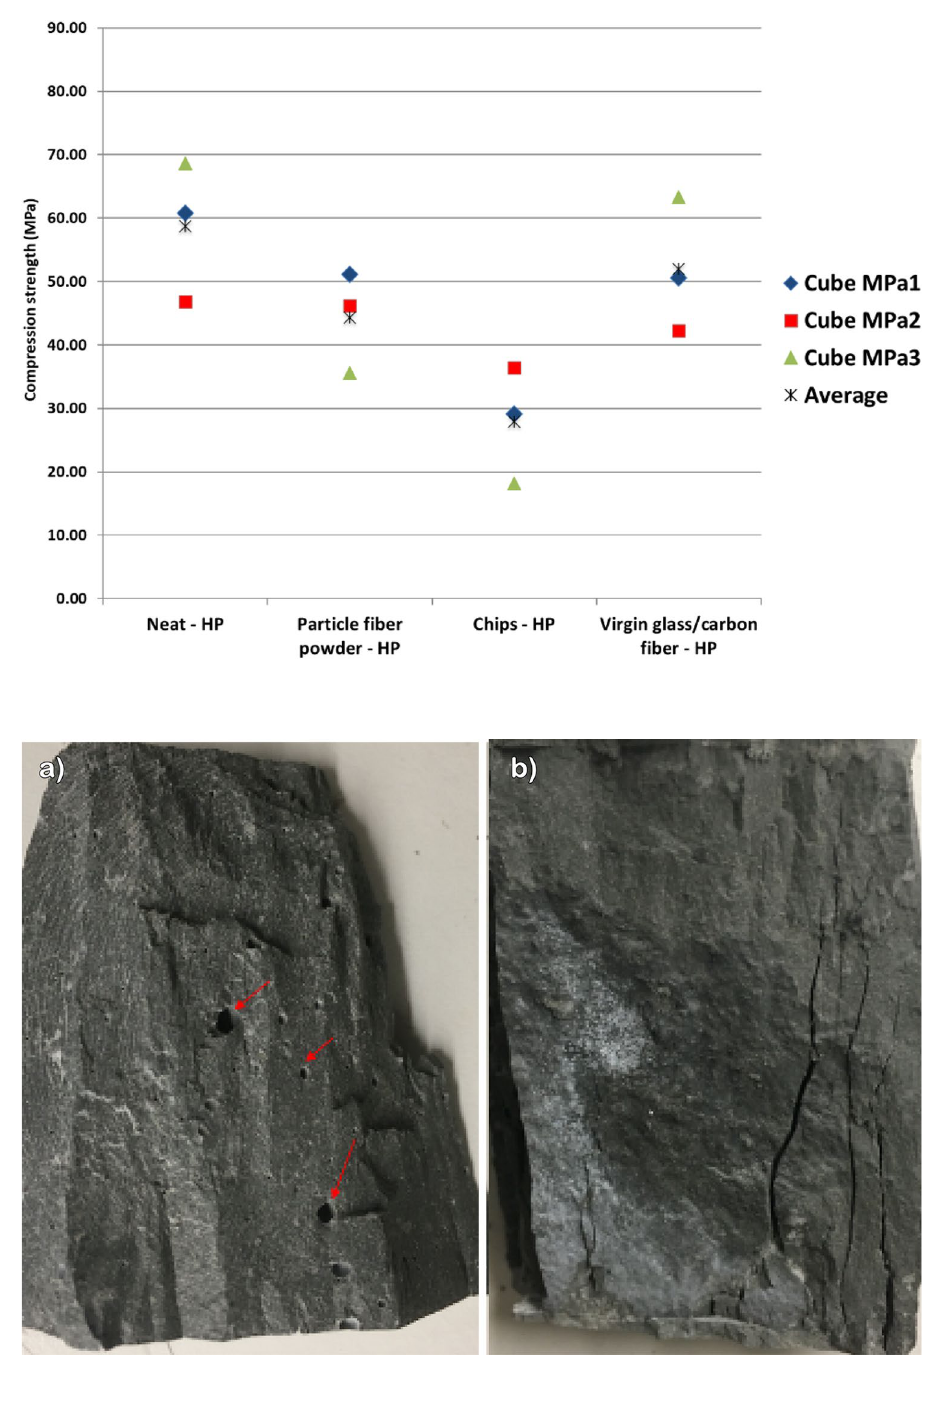
Fig. 7 Compression strengths of the high-pressure com- pacted unaged cement sam- ples with and without recycled admixtures cured for 180 days